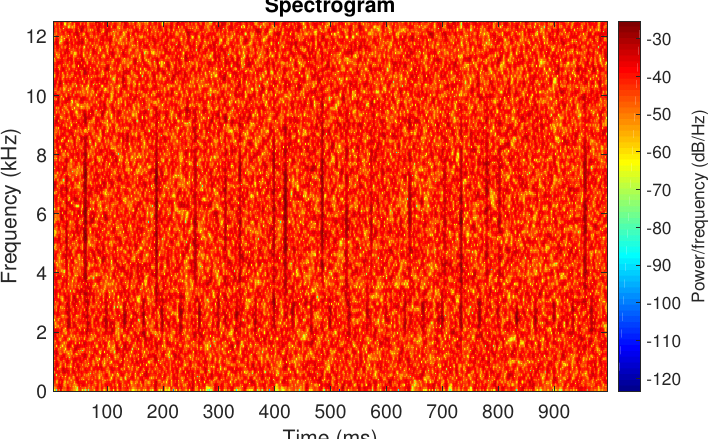
Figure 3. Spectrogram of the simulated signal s 1 .